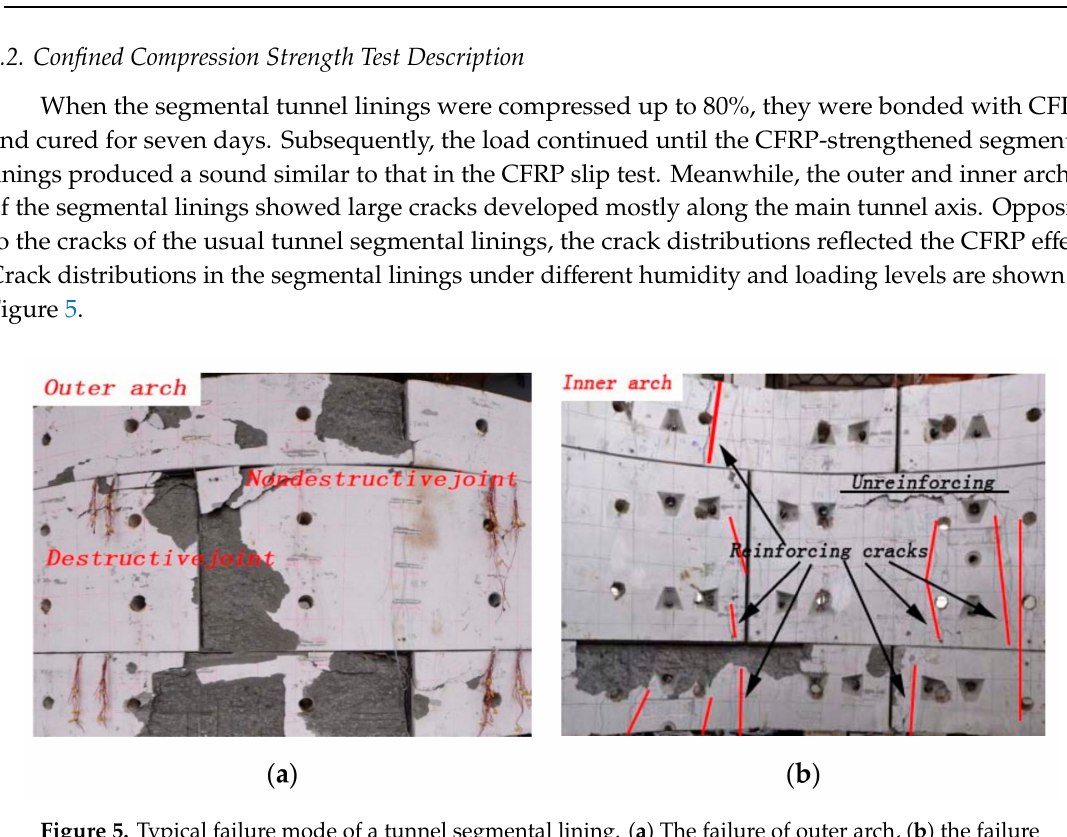
Figure 5. Typical failure mode of a tunnel segmental lining. ( a ) The failure of outer arch, ( b ) the failure of inner